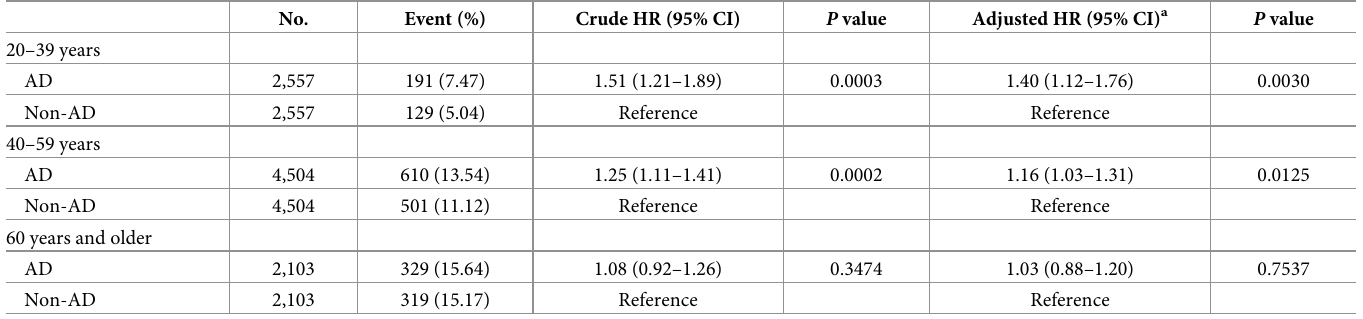
Table 4. Subgroup analysis of GERD risk based on